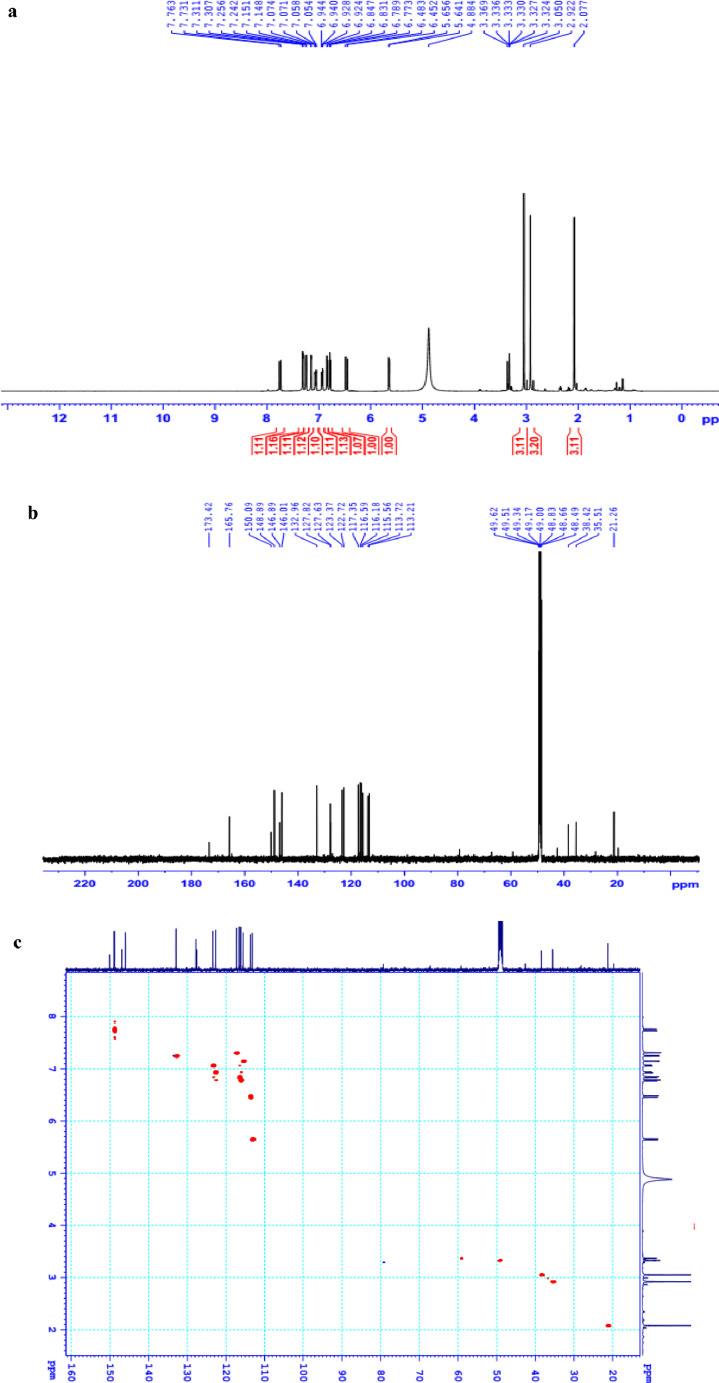
a. 1H NMR (500 MHz, CD3OD) of 3, b. 13C NMR (125 MHz, CD3OD) of 3, c. HSQC of 3, d. HMBC of 3, e. (-) APCI-MS of 3.